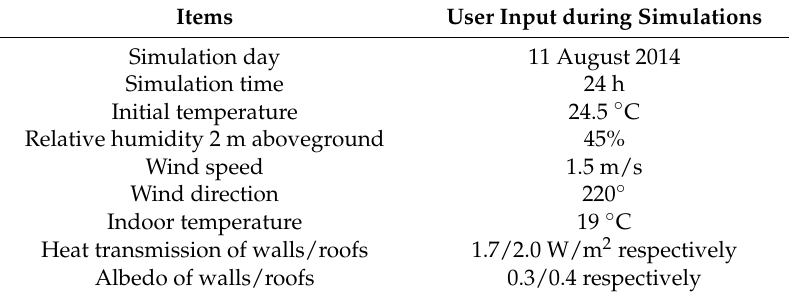
Table 1. The main input parameters of the ENVI-met